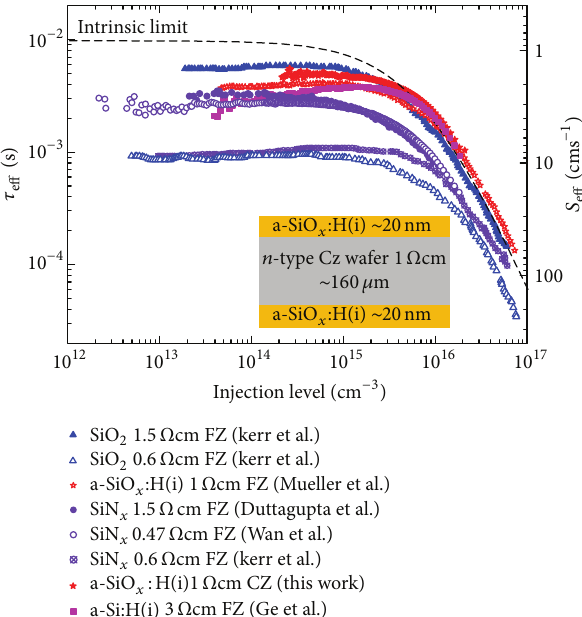
Figure 11: Measured QSSPC lifetime of optimized a-SiO 𝑥 :H(i) film as a function of minority carrier injection level. The calculation of effective surface recombination velocity is based on wafer thickness of our samples. The dashed line represents intrinsic limit of the 1 Ω cm wafer assuming no extrinsic recombination [27]. As a comparison, other high-quality passivation schemes from Mark and Andres [28, 29], Duttagupta et al. [30], Wan et al. [31], Mueller et al. [16,18],andGeetal.[10]arealsoshowninthegraph.Theinsetshows the sample structure for ICP a-SiO 𝑥 :H(i) passivation.